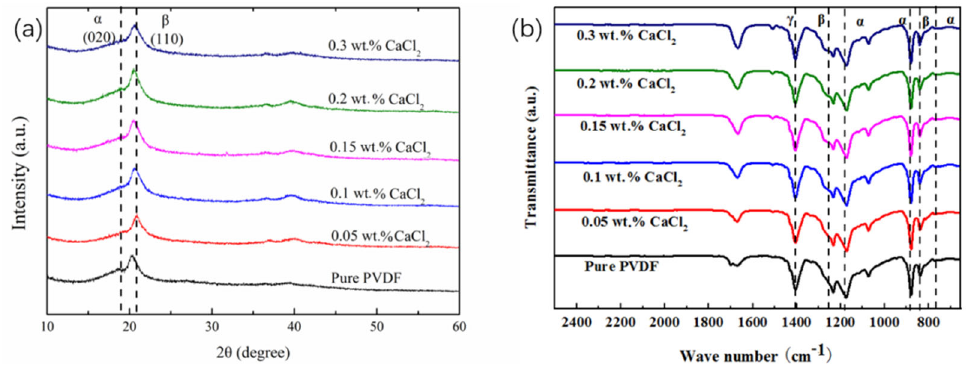
Figure 5. ( a ) XRD patterns and ( b ) FTIR spectra of PVDF/CaCl 2 composite films.